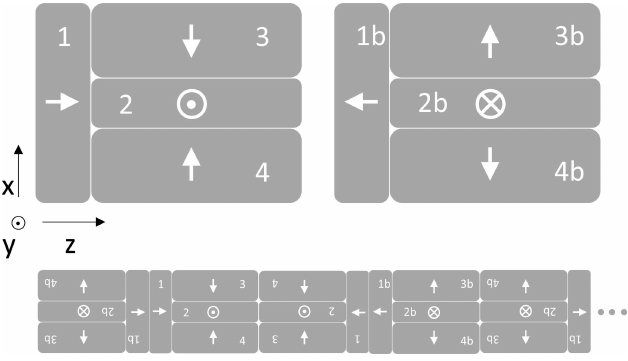
Figure 2 Details of the half pole magnet assembly in its xz -plane projection. The two polarities are presented on the left and on the right with which is possible to build the full